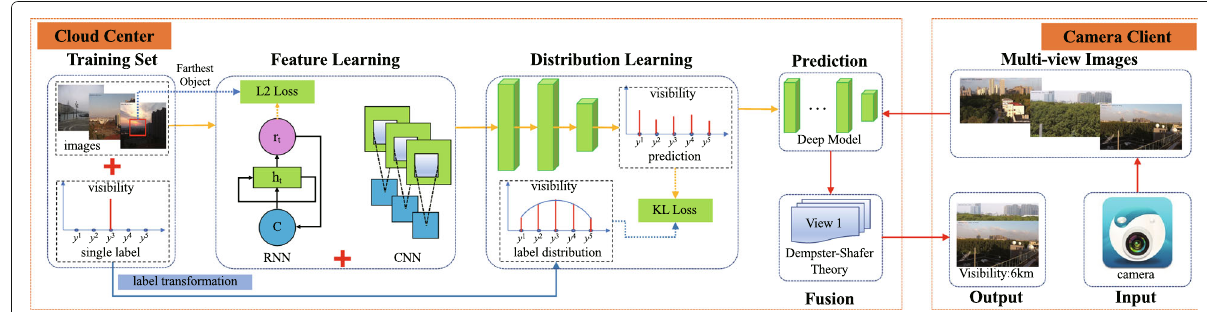
Fig. 2 The overall process of our method